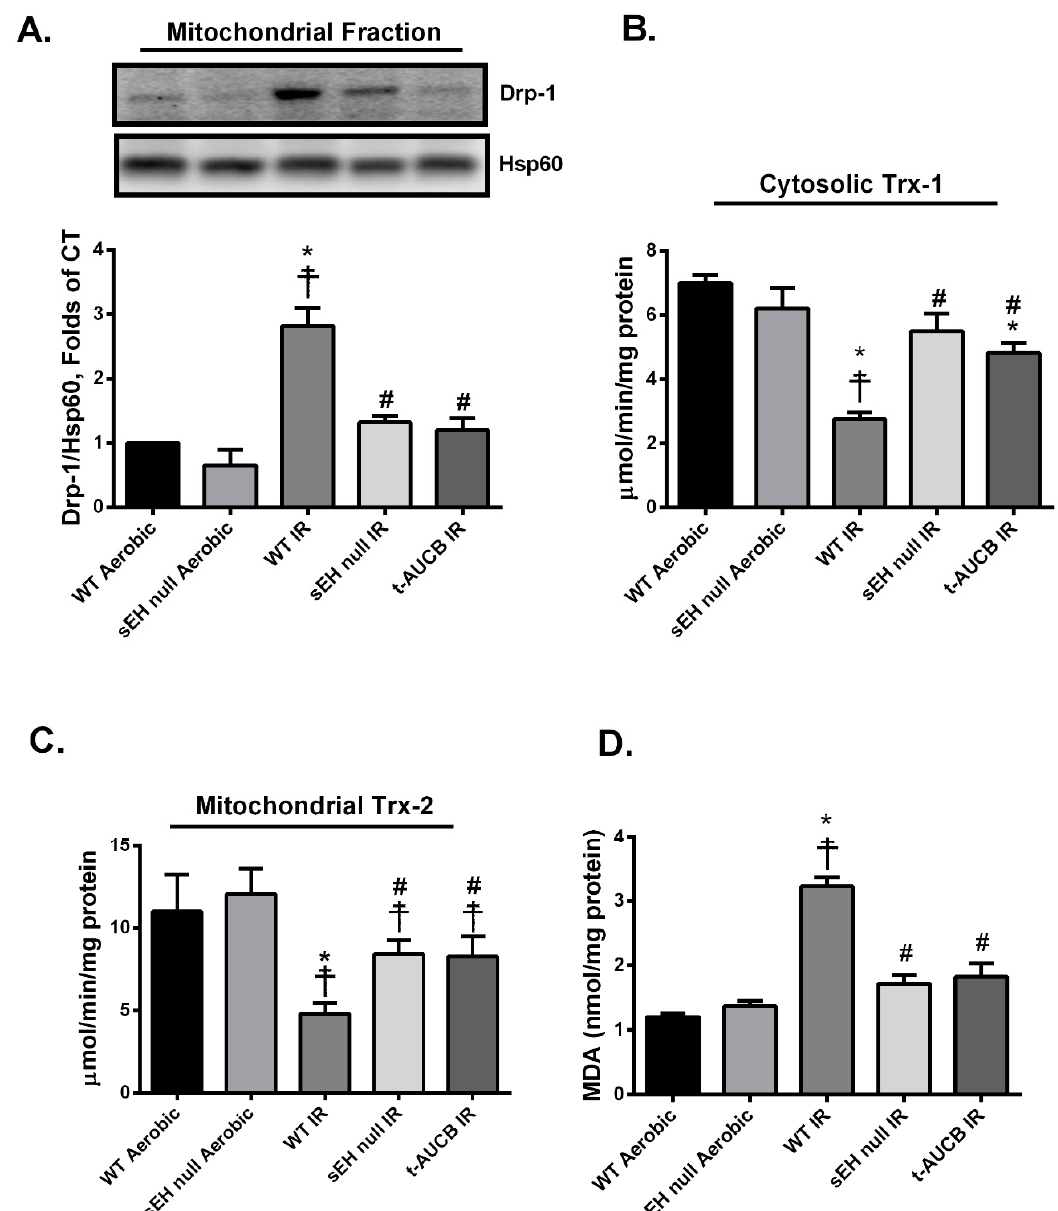
Figure 3. Deficiency of sEH preserved mitochondrial integrity and limited oxidative stress following ischemia / reperfusion (IR) injury. ( A ) Representative immunoblots and densiometric quantification of the expression of mitochondrial protein Drp-1 in mice hearts after 30 min ischemia and 40 min reperfusion. Protein expression was normalized to heat shock protein 60 (Hsp60) used as a loading control. Cardiac ( B ) cytosolic thioredoxin (Trx)-1 and ( C ) mitochondrial Trx-2 activities were assessed in hearts following 30 min ischemia and 40 min reperfusion. Trx activity was assessed using the insulin disulfide reduction assay. In this assay, by using an excess of NADPH and thioredoxin reductase (TrxR) enzyme, Trx activity was measured via the oxidation of NADPH and the generation of free SH groups in reduced insulin by 5,5’-dithiobis-(2-nitrobenzoic acid) (DTNB) after stopping the reaction with guanidine–HCl. ( D ) Cardiac MDA levels assessed using a lipid peroxidation (MDA) colorimetric assay kit in mice hearts following 30 min ischemia and 40 min reperfusion. Values represent mean ± SEM, * p < 0.05 vs. WT Aerobic CT, ☨ p < 0.05 vs. sEH null Aerobic, # p < 0.05 vs. WT IR ( n = 3 – 5 per group).